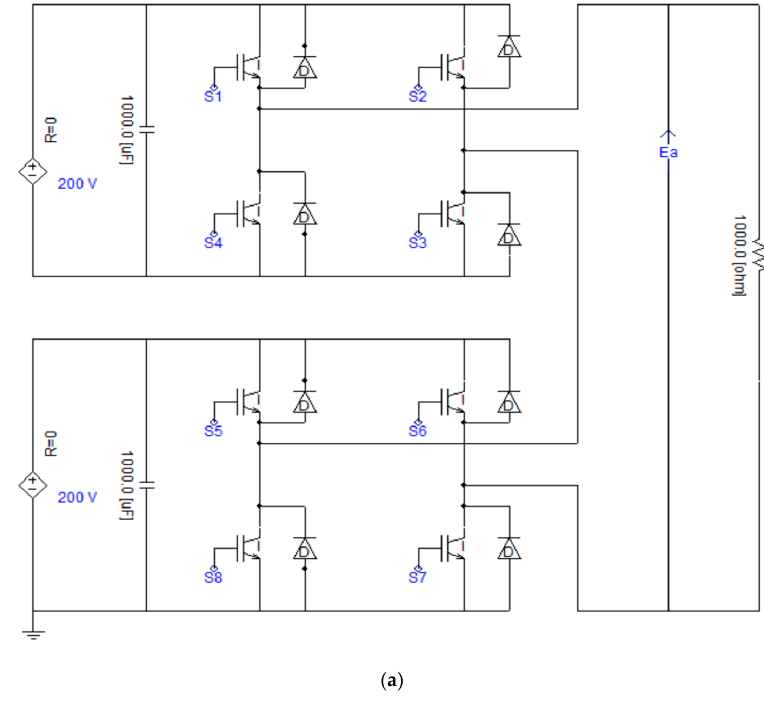
Table 4. Voltage levels of 5-level CHB-MLI and switching states.